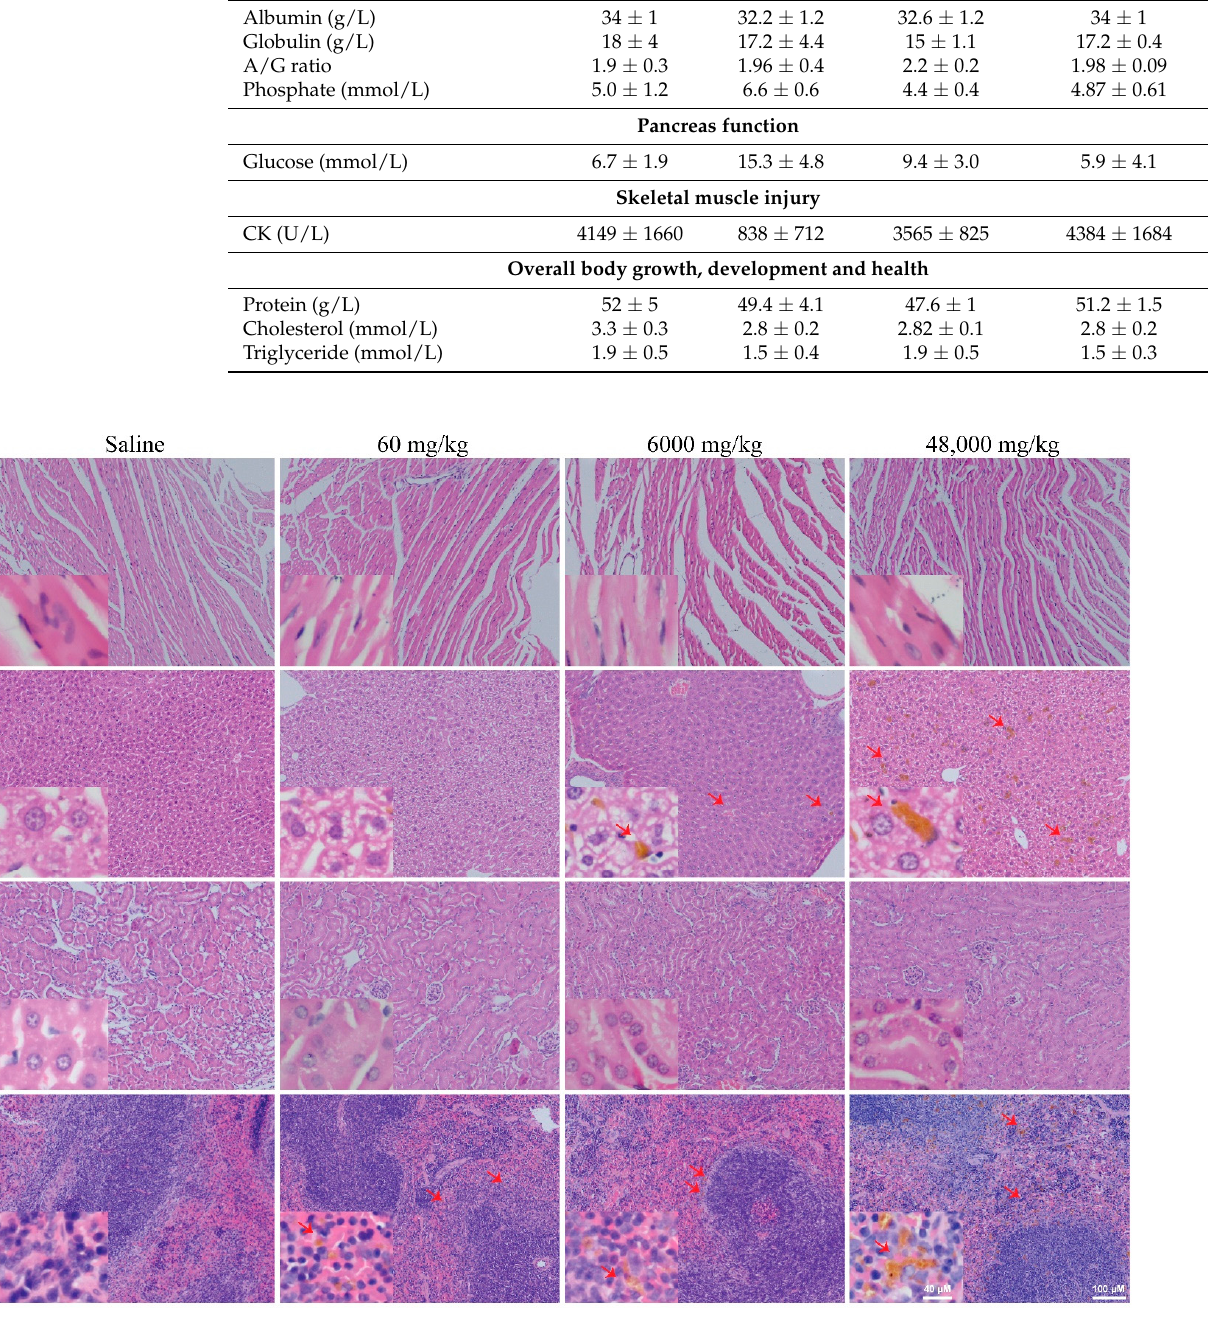
Figure 9. Histopathology of mice organs receiving accumulated concentrations of 60, 6000, and 48,000 mg/kg after 14 days following the first IV administration. Sparse PPN deposits ( ≤ 100 µm) were observed mainly in the liver and spleen at the higher dosages, as indicated by the red arrows. No major abnormalities in organ structure were detected for all the PPN concentrations tested. Scale bars represent 40 µ m (insets) and 100 µ